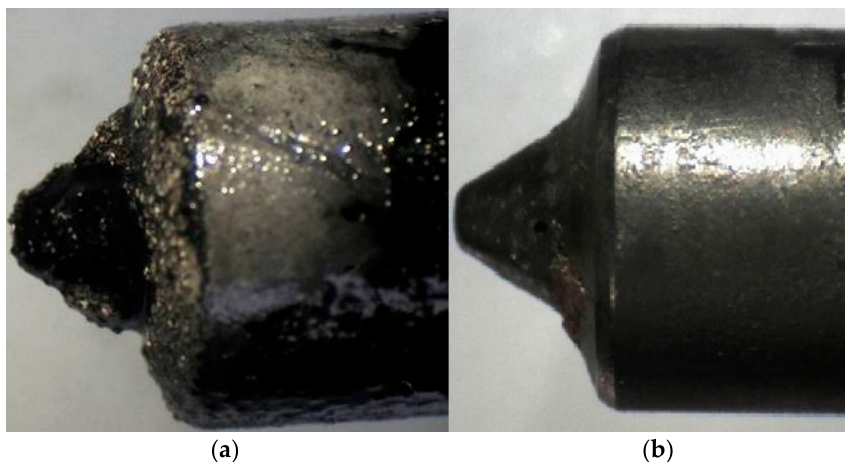
Figure 13. RF91 nozzle tip magnified ( a ) after 100 h operation with B20 and B50, including 50 ppm cerium-doped fuel additive; and ( b ) after ultrasonic cleaning.